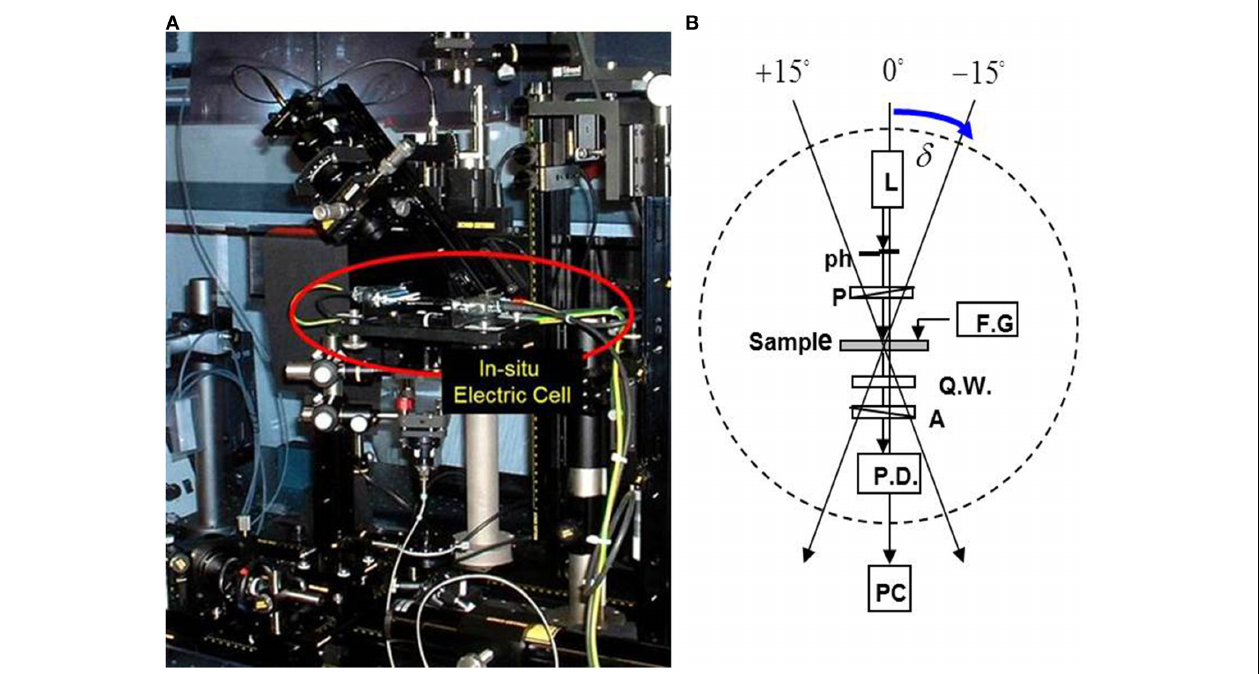
FIGURE 3 | (A) A photograph of the in-situ small angle dynamic light scattering set up, where the in-situ electric cell is located within the red circle. (B) A sketch of the electric birefringence setup: The optical rail is